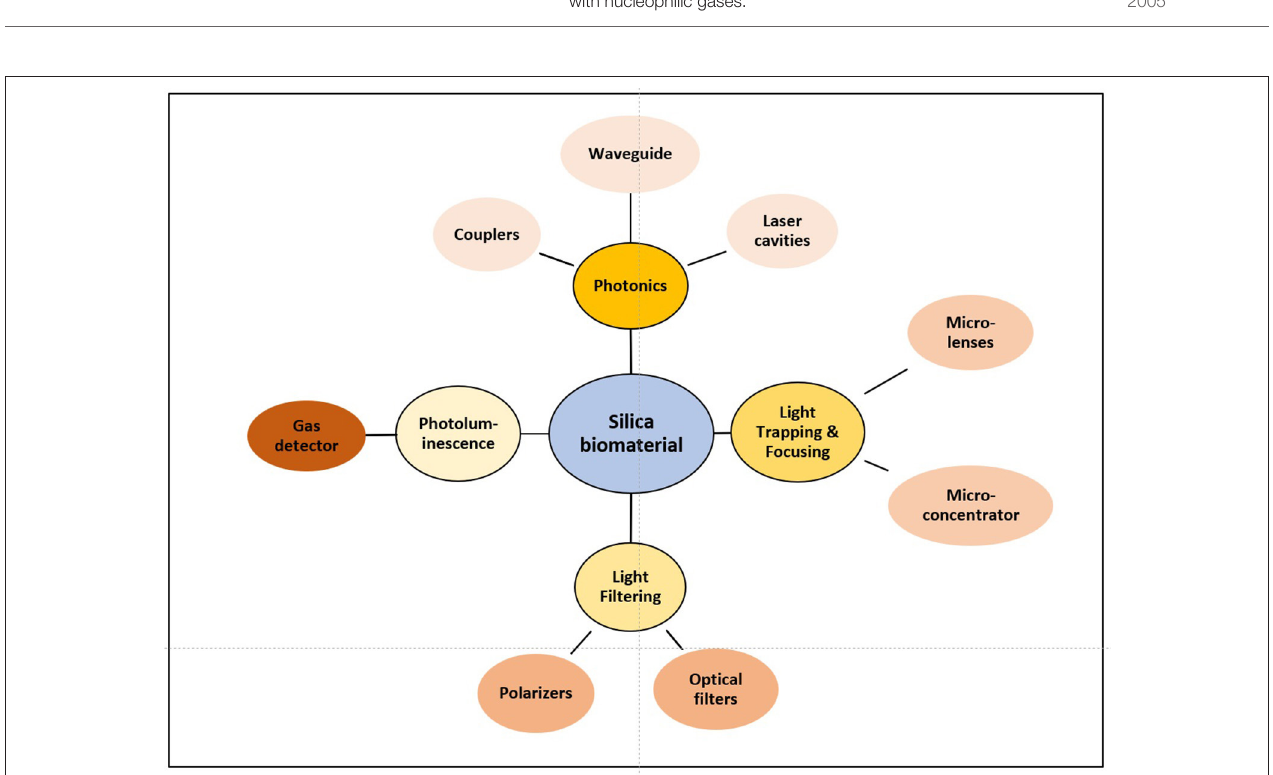
FIGURE 4 | Schematic representation of biosilica properties and their potential applications.